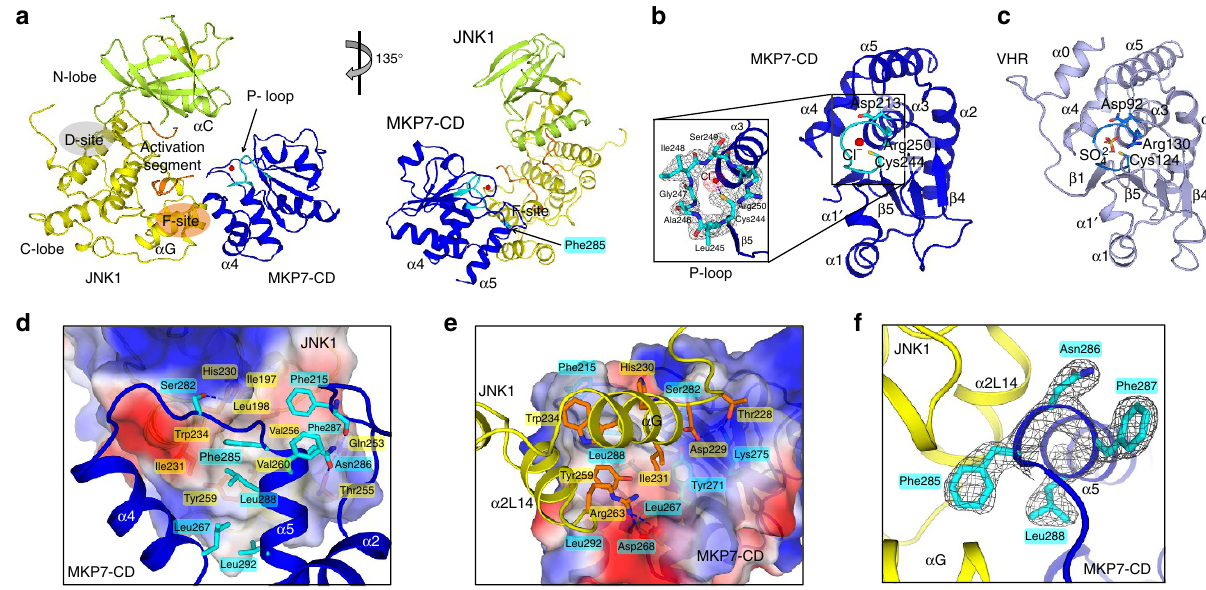
Figure 3 | Structure of JNK1 in complex with MKP7-CD. ( a ) Ribbon diagram of JNK1–MKP7-CD complex in two views related by a 45 (cid:2) rotation around a vertical axis. ( b ) Structure of MKP7-CD with its active site highlight in cyan. The 2 F o (cid:3) F c omit map (contoured at 1.5 s ) for the P-loop of MKP7-CD is shown at inset of b . ( c ) Structure of VHR with its active site highlighted in marine blue. ( d ) Close-up view of the JNK1–MKP7 interface showing interacting amino acids of JNK1 (orange) and MKP7-CD (cyan). The JNK1 is shown in surface representation coloured according to electrostatic potential (positive, blue; negative, red). ( e ) Interaction networks mainly involving helices a 4 and a 5 from MKP7-CD, and a G and a 2L14 of JNK1. MKP7-CD is shown in surface representation coloured according to electrostatic potential (positive, blue; negative, red). Blue dashed lines represent polar interactions. ( f ) The 2 F o (cid:3) F c omit map (contoured at 1.5 s ) clearly shows electron density for the 285 FNFL 288 segment of MKP7-CD.